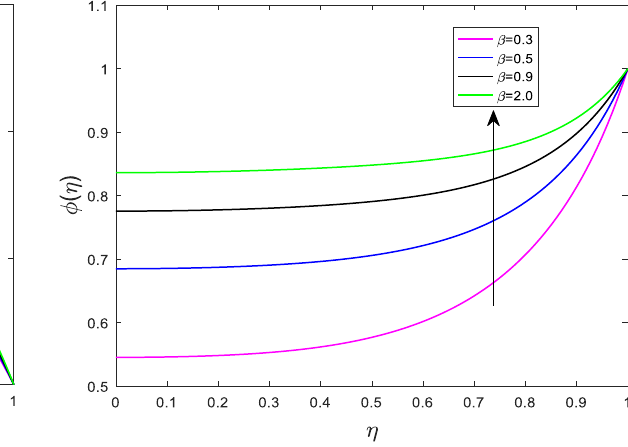
Figure 9: Effect of β on ϕ ( η ) for fixed S = 6.0, Ha = Ω C = N t = Kr = 0.1, Ω = Ec = 0.5, N = 0.3, Pr = 1.5 and Sc = b T